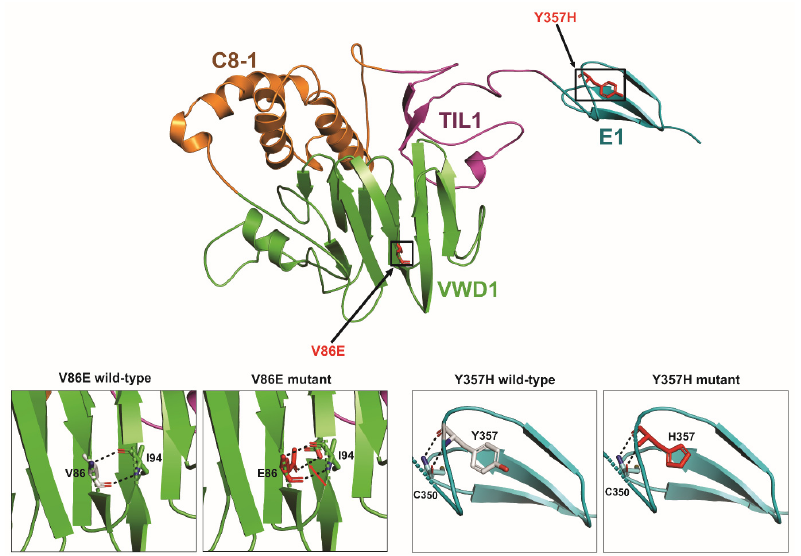
Figure 4. The 3D protein modelling of VWF p.Val86Glu and p.Tyr357His pathogenic variants. The predicted crystal structure of human VWF protein (D1 domain) is presented on the top. The modular domain organization features highlighted as von Willebrand D domain (vWD in green), 8 cysteines (C8 in orange), trypsin inhibitor-like (TIL in magenta), and E (in analogy to the A, C, and D repeats in VWF in cyan). The black open squares locate the p.V86E and p.Y357H mutations in the vWD1 and E1 domains, respectively. The inserts on the lower left depict the aberrant polar contacts induced by p.V86E mutation where amino acid residues involved in polar contacts are shown as stick models with carbon atoms for V86, E86 and I94 in grey, red and green, respectively. Likewise, the inserts on the lower right indicate conformational changes resulting from p.Y357H mutation.